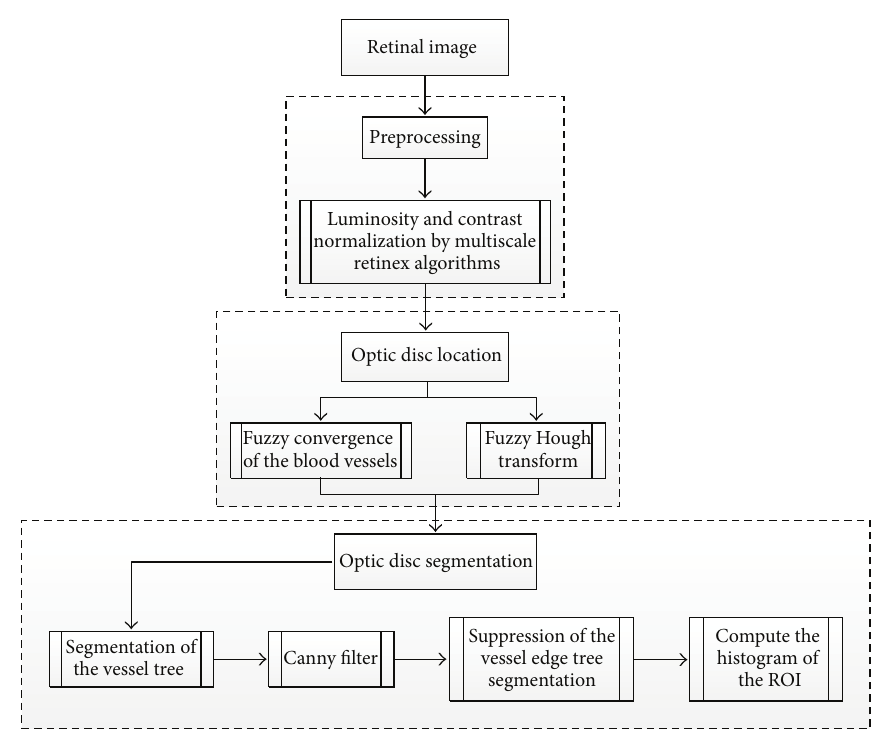
Figure 6: Flowchart for algorithm proposed in